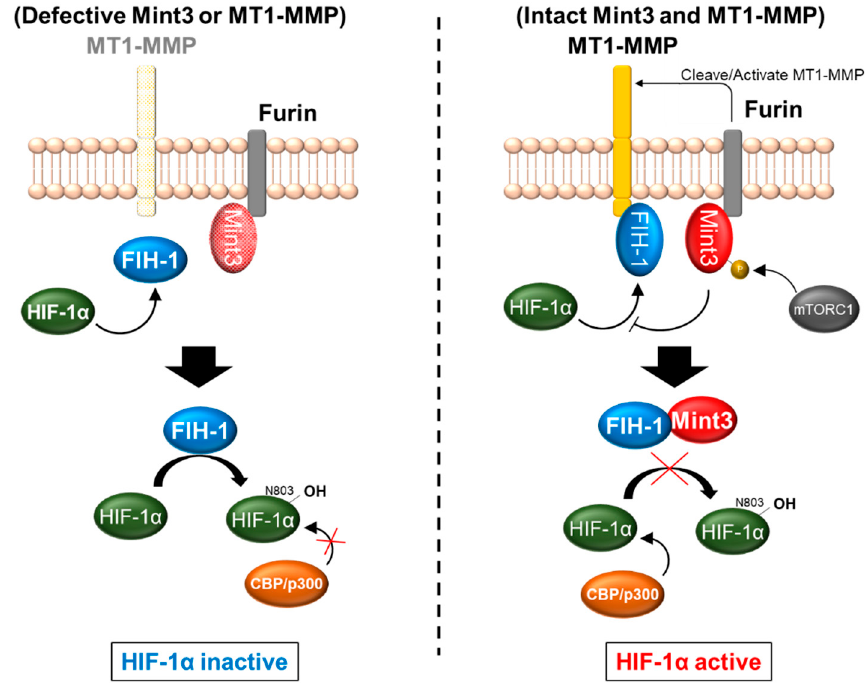
Figure 2. Mint3 indirectly activates HIF-1 α . Mint3 binds with factors inhibiting HIF-1 (FIH-1) upon furin-mediated activation of membrane type 1-matrix metalloproteinase (MT1-MMP) followed by FIH-1 defected in the ability to suppress HIF-1 α . Mint3 progress HIF-1 α -mediated phenomenon including glycolysis, acute inflammation, and cancer progression and metastasis.